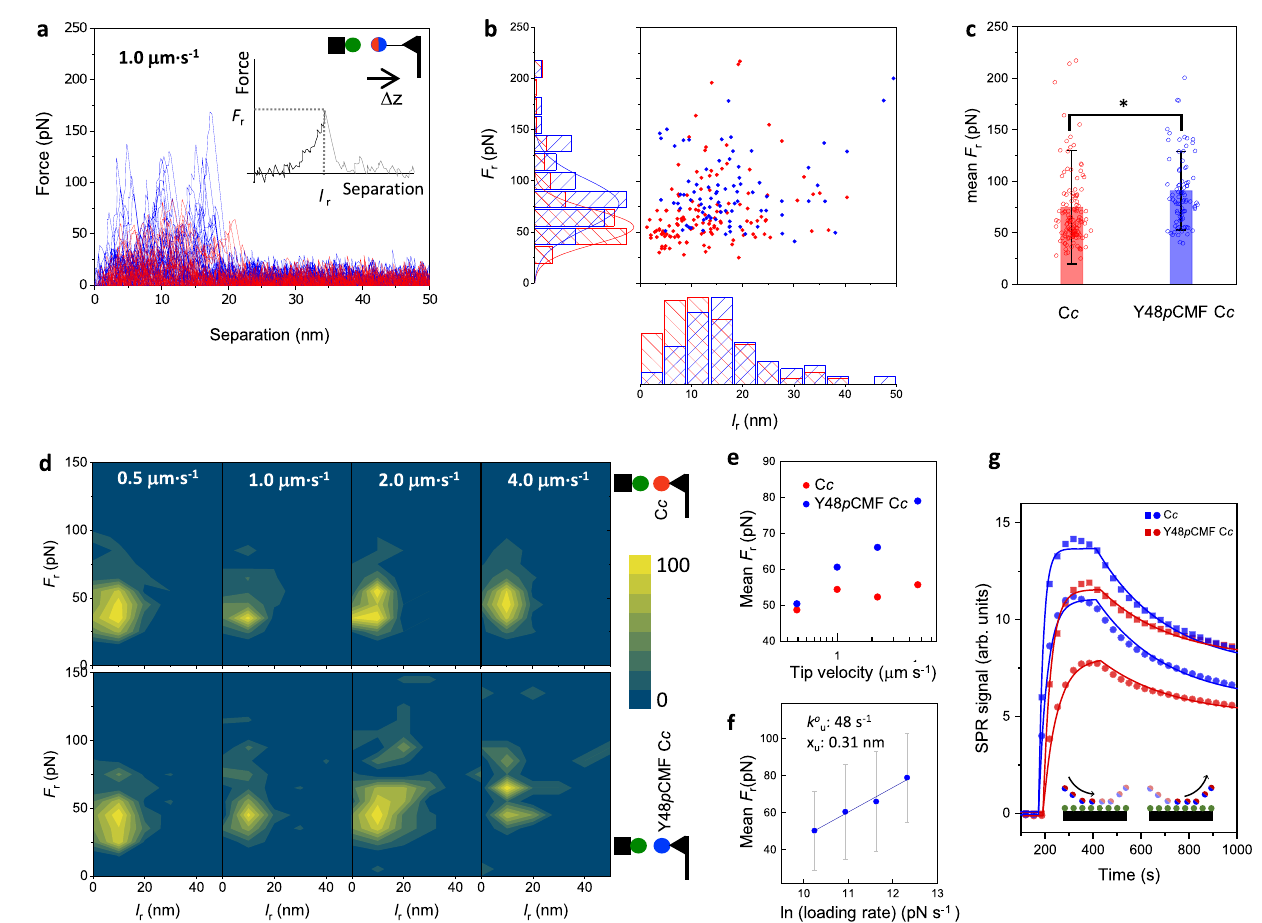
Fig. 3 | Unbinding between C c 1 -C c studied by AFM-FS single molecule and surface plasmon resonance (SPR) ensemble measurements. a Representative force-separation unbinding events upon tip retraction at 1 μ m·s − 1 for C c 1 -C c (red) and C c 1 -Y48 p CMF C c (blue), when C c 1 is directly anchored to Au(111) and C c is anchoredtotheAFMtipthroughaPEG 27 linker.Theinsetshowstheparameters F r and l r , that are collected from each curve and displayed in b as F r vs . l r with the corresponding histograms in each axis. F r distributions are fi tted to a Gaussian. c Plot of the averaged F r values (mean±s.d.) for C c 1 -C c (n=134 force-separation curves from 2 independent experiments, red) and C c 1 -Y48 p CMF C c (n=88 force- separation curves from 3 independent experiments, blue), showing signi fi cant differences (two sample t-test, t Statistic = 2.34, degrees of freedom = 220, *P=0.02). d F r vs . l r contourmapsfortheunbindingatdifferentpullingrates(0.5 − 4.0 μ m·s − 1 ) for C c 1 -C c (top, n=212, 185, 55 and 226 for 0.5, 1.0, 2.0 and 4.0 μ m·s − 1 ,